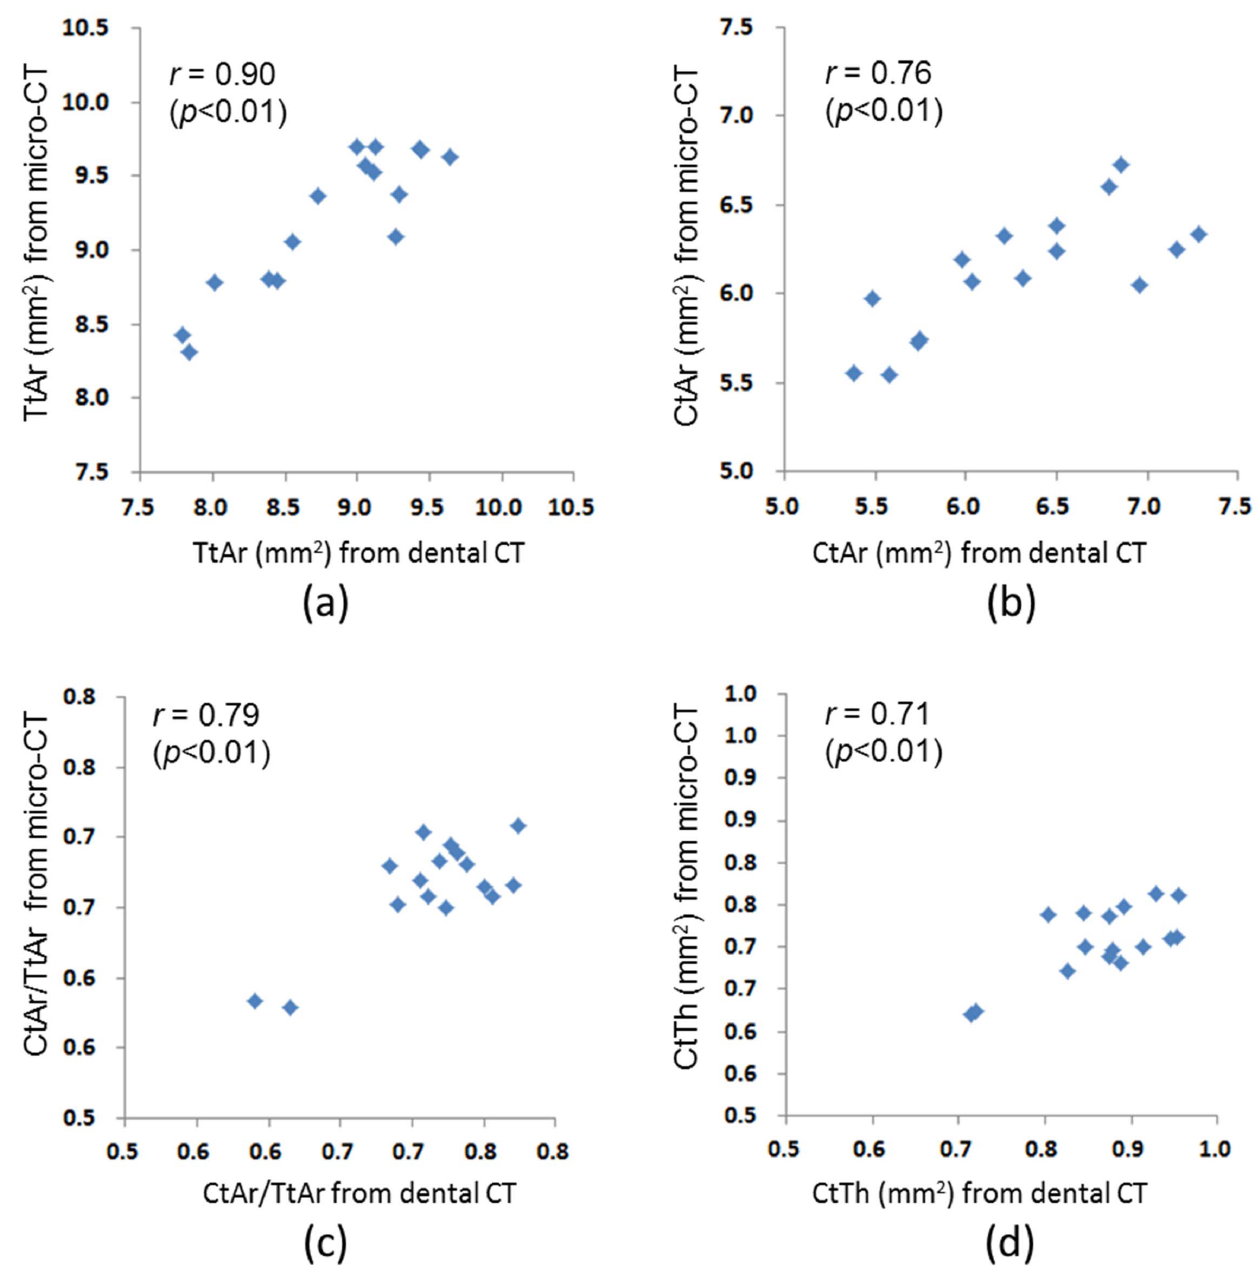
Figure 4. Correlations of the (a)TtAr, (b)CtAr, (c)CtAr/TtAr, (d)CtTh measured by micro-CT and dental CT.